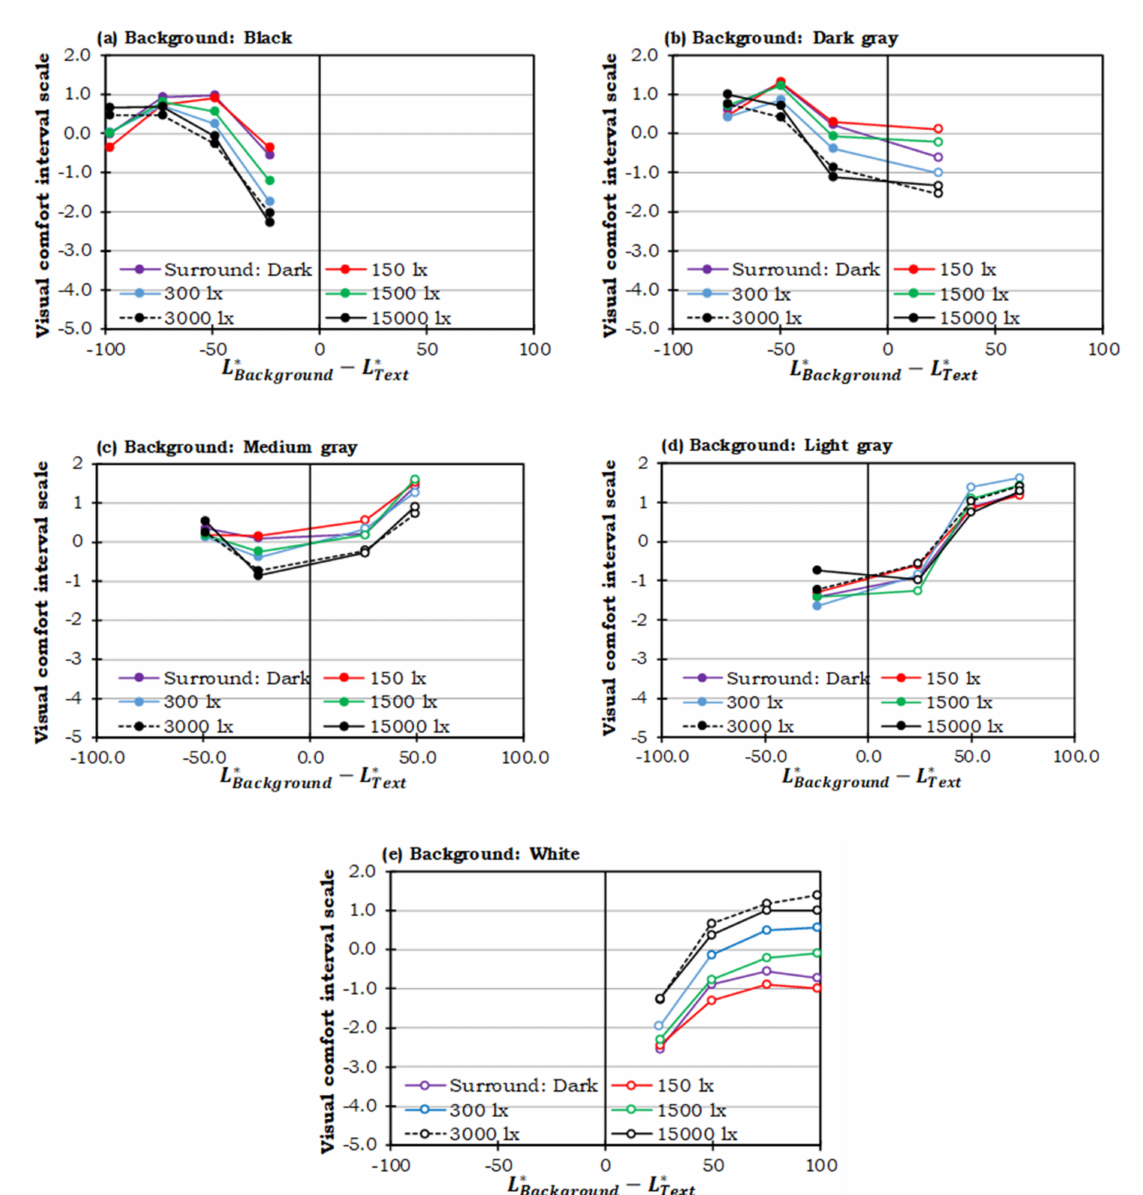
Figure 9. Comparisons of the visual comfort interval scales between six illuminance levels at each background ( a ) Black ( b ) Dark gray ( c ) Medium gray ( d ) Light gray ( e ) White; the open symbols are used to differentiate the positive contrast text-background